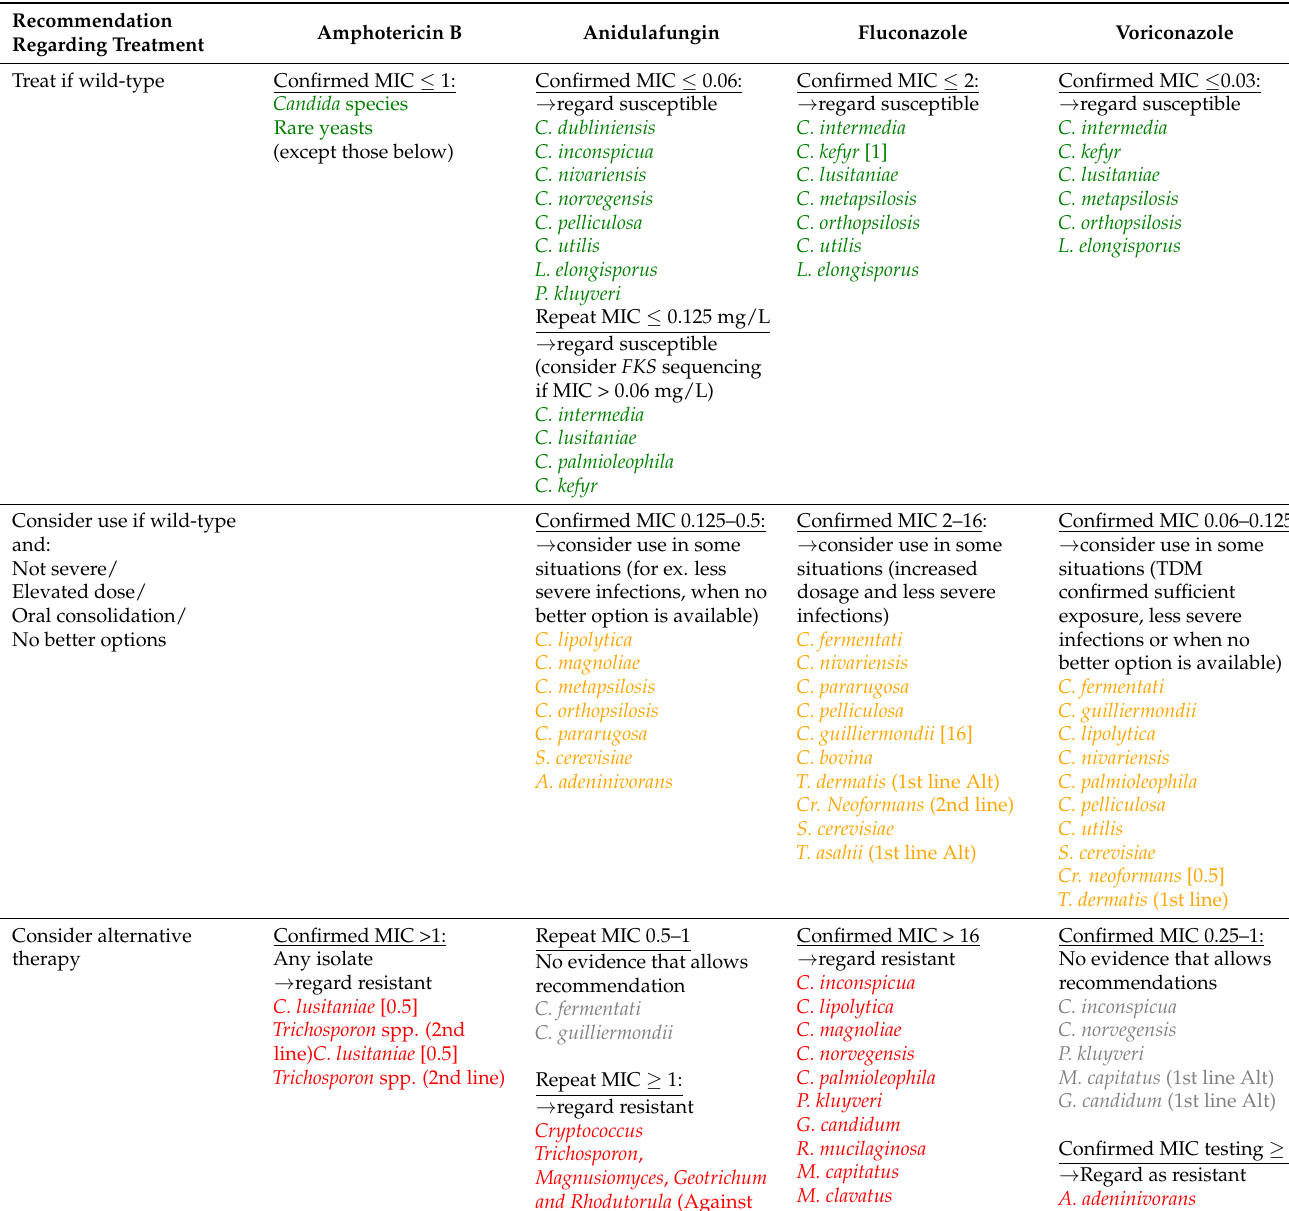
Table 3. Overview of pragmatic BPs for the rare yeast species. The colour denotes the intrinsic relative susceptibility (S (green)/I (orange)/R (red)/Unknown (grey)) of wild-type isolates (isolates with modal MICs (mg/L) in the indicated range). Isolates with MICs above the indicated species-specific values (and thus non-wild-type) should be regarded